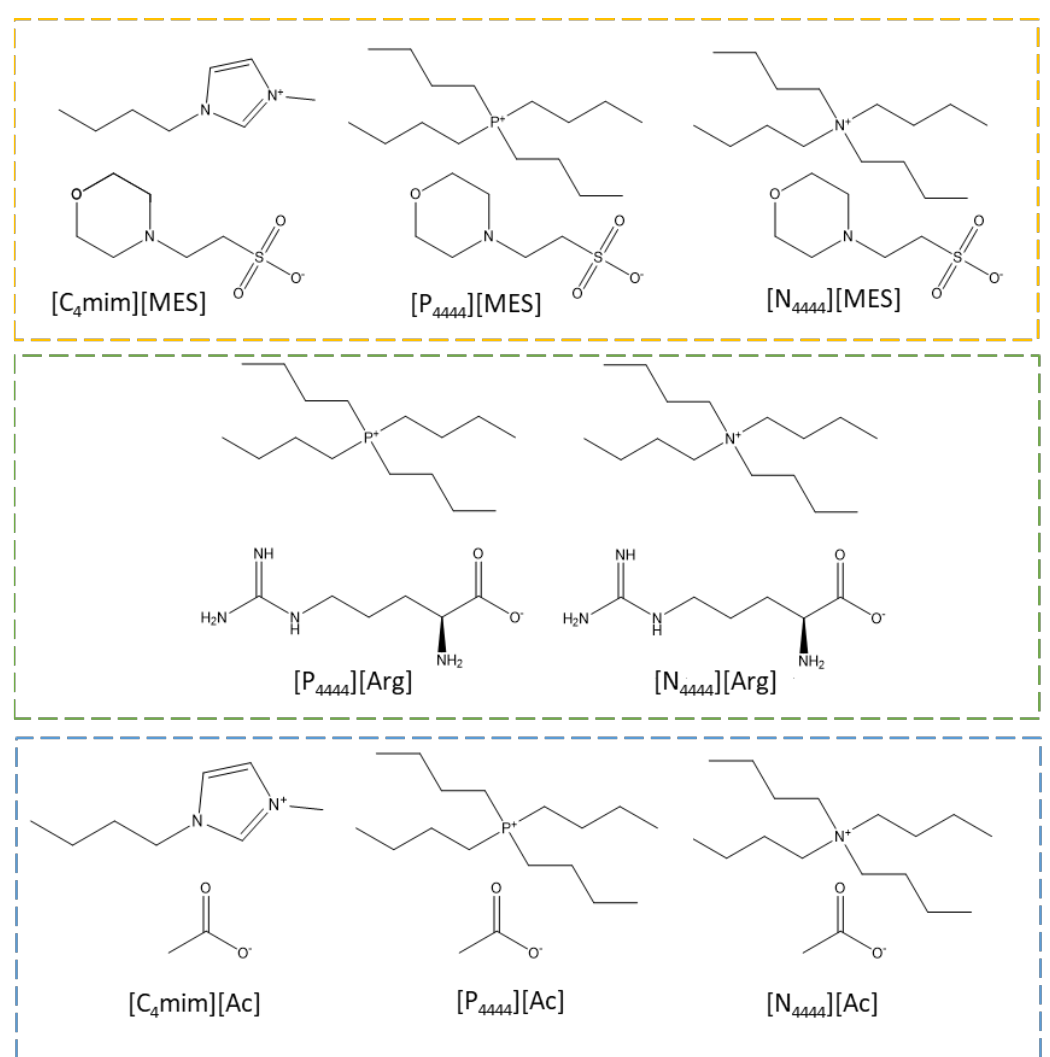
Figure 1. Chemical structures of the ionic liquids investigated.